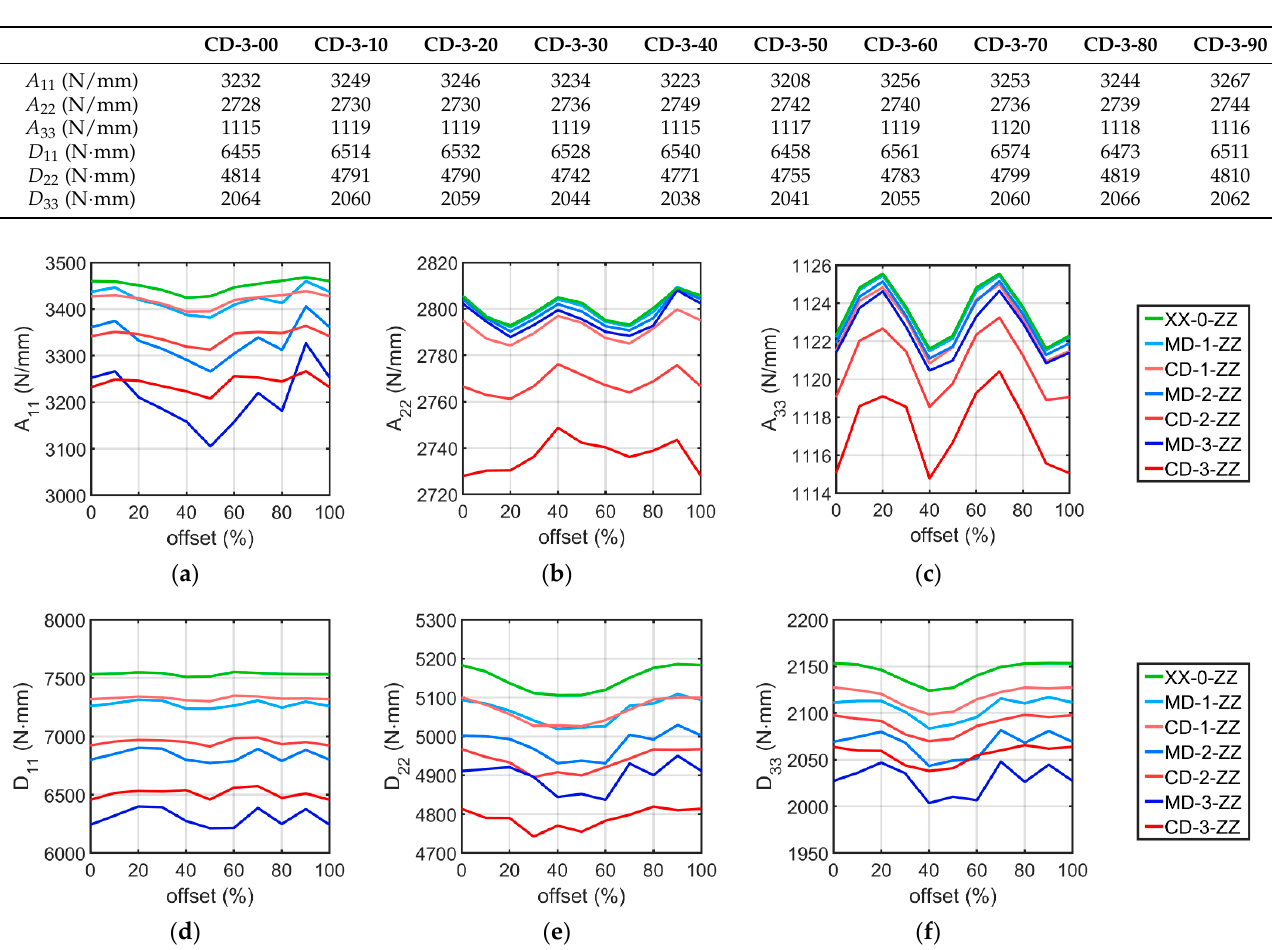
Table 10. The selected stiffnesses with 3% imperfections of compression in the CD shape and with different offsets.